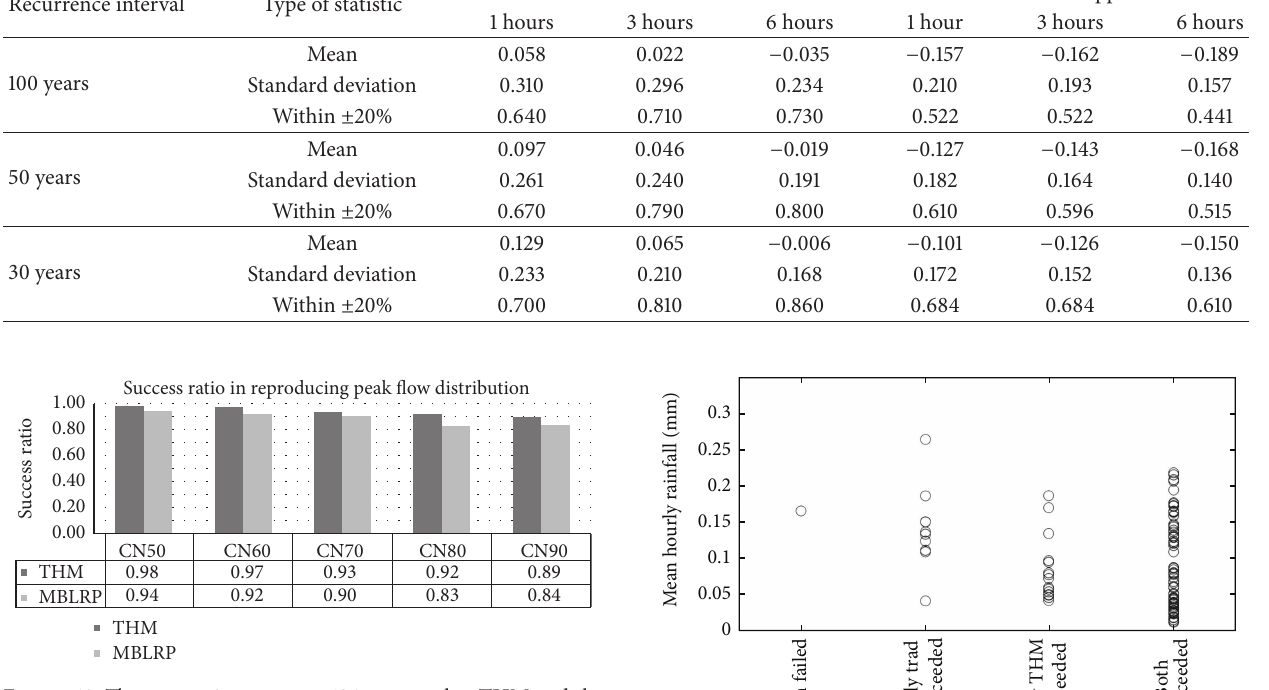
Figure 13: The proportions, among 104 gauges, that THM and the traditional approach succeeded in reproducing the distribution of the observed peak flows of the hypothetical watershed with curve numbers of 50, 60, 70, 80, and 90.